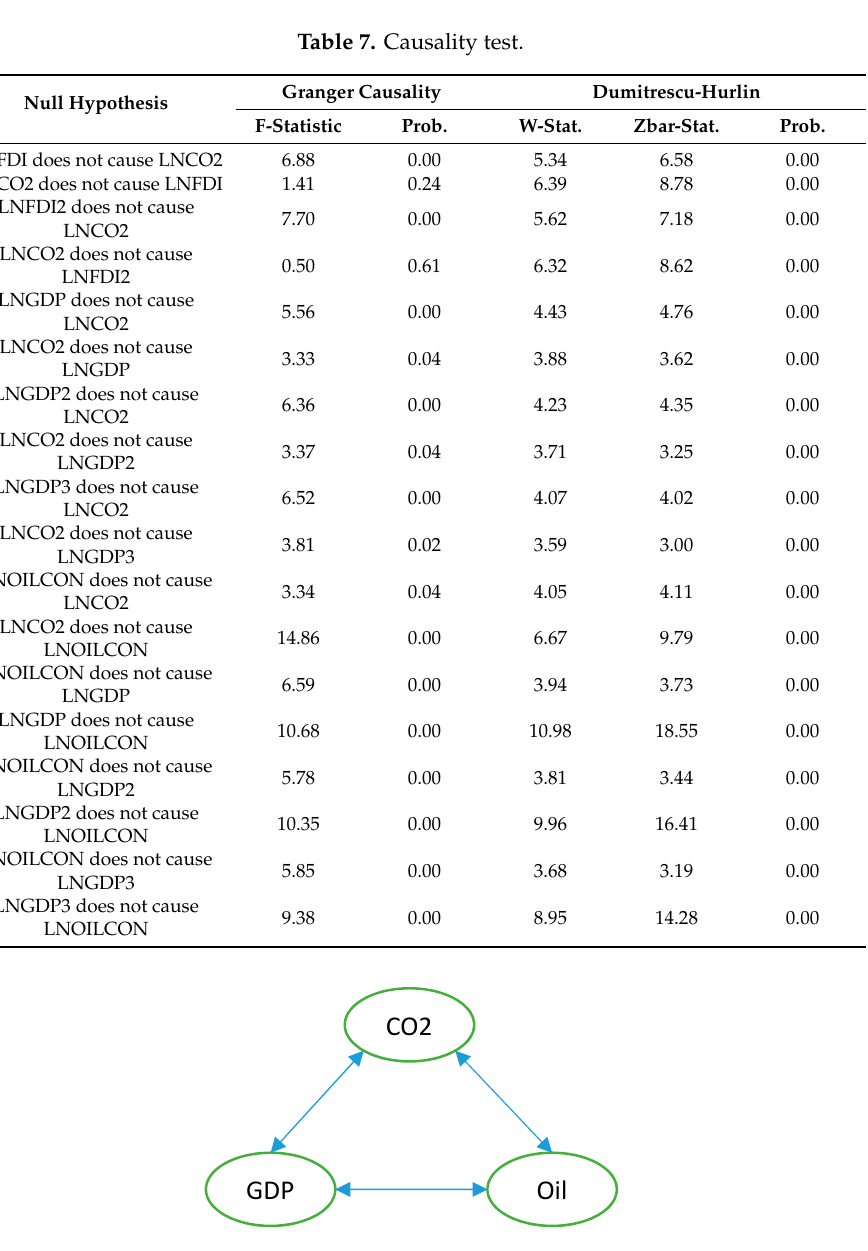
Table 7. Causality test.